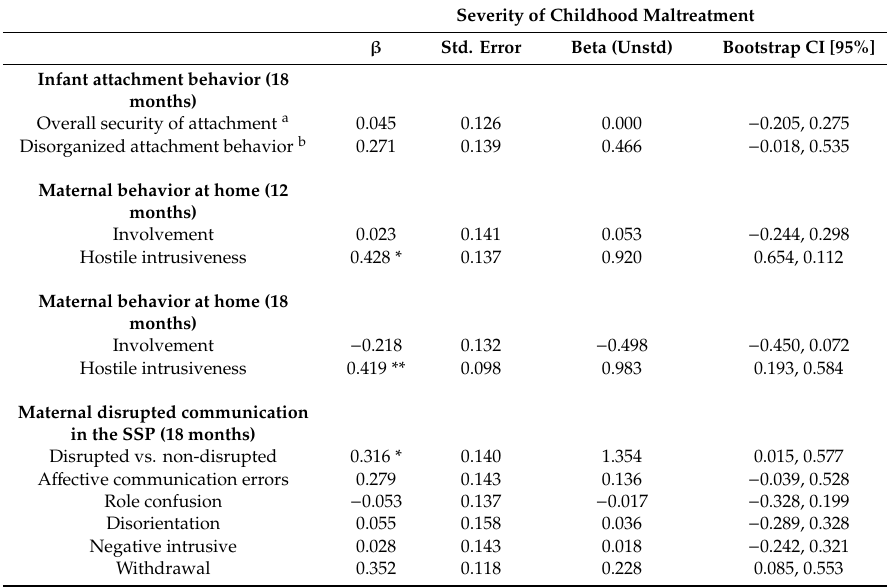
Table 2. Regression results for associations between mother–child interactions during infancy and severity of childhood maltreatment by age